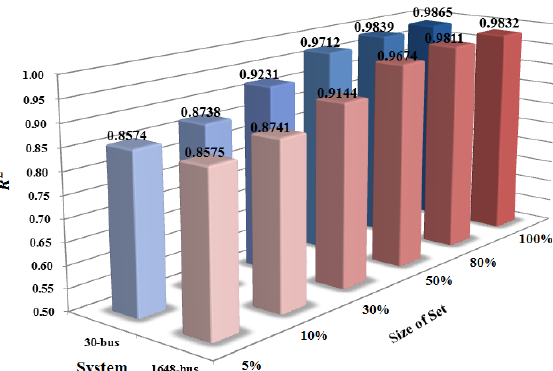
Figure 10. Assessment accuracies (residual squared error ( R 2 )) based on different training set sizes.